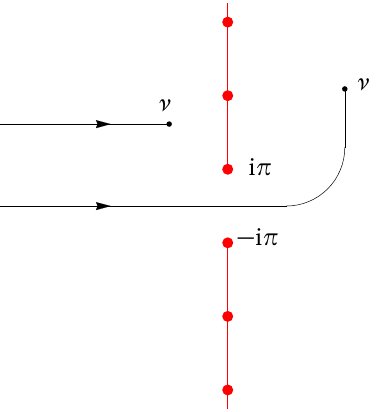
( ν ) in (68) and for J ( ν ) in P 0